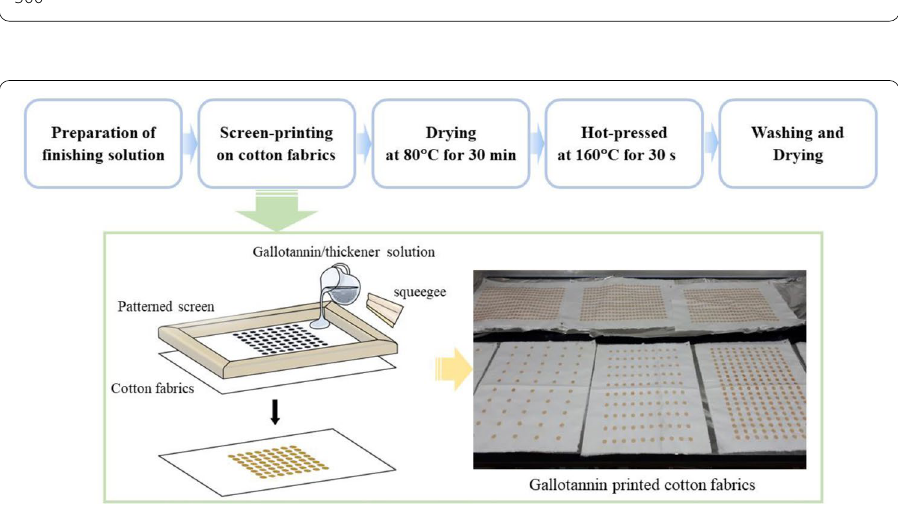
Fig. 2 Schematic diagram showing the screen-printing